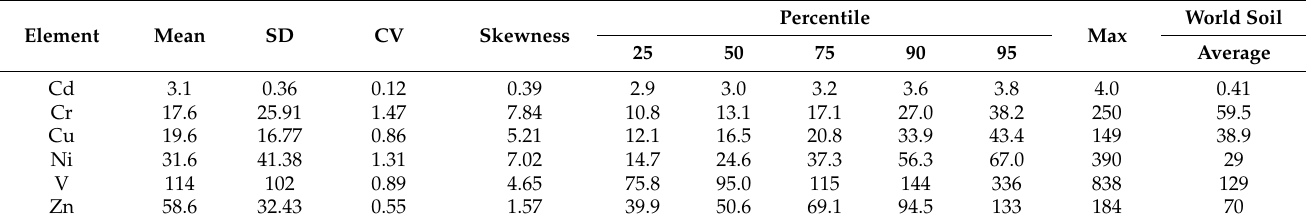
Table 1. Summary statistics of heavy metals’ concentrations (mg × kg − 1 ) in Coronel.